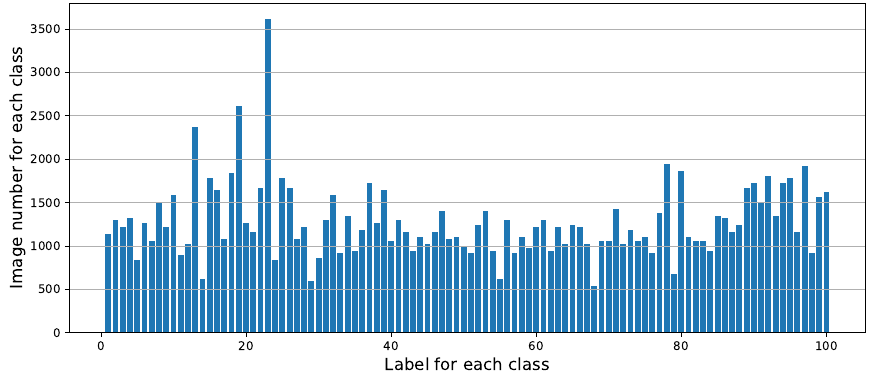
Figure 6. The number of samples in each category of the augmented OBI-100 dataset.